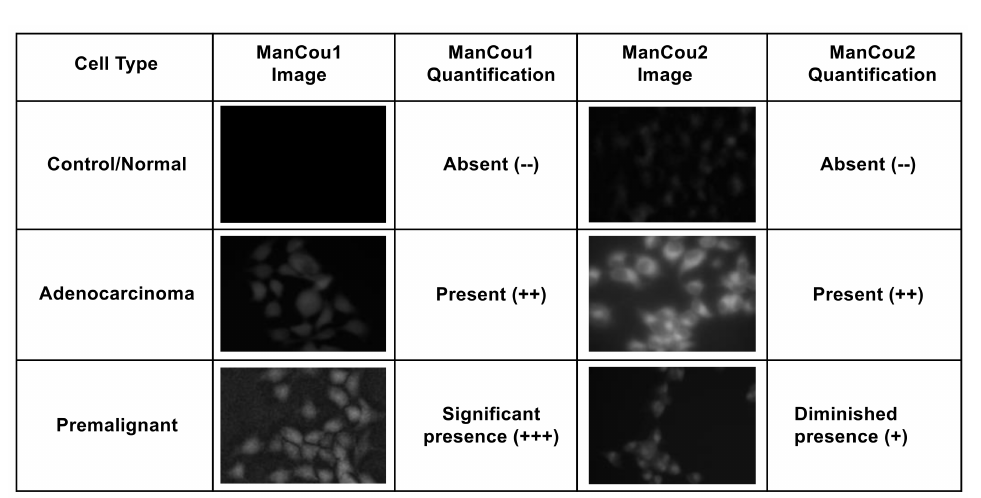
Figure 7. An example two-point analysis demonstrating the identification of normal, adenocarcinoma, and premalignant